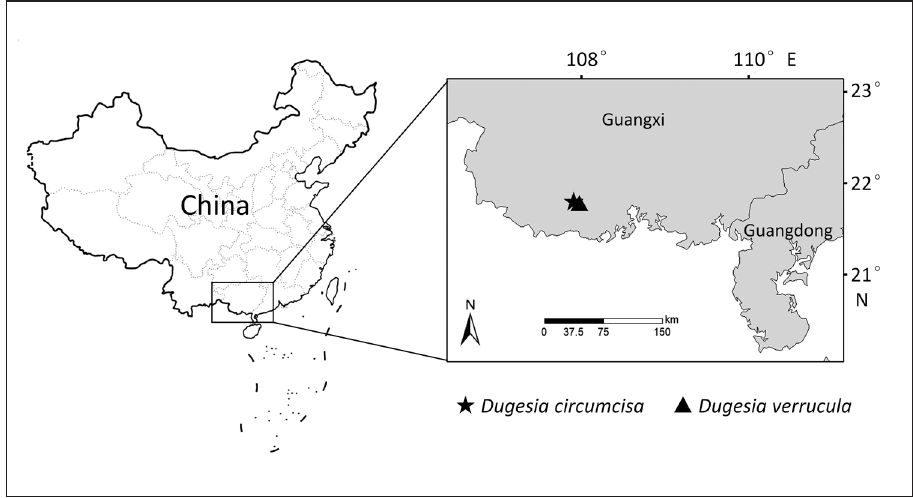
Figure 1. Collection sites of Dugesia in Guangxi